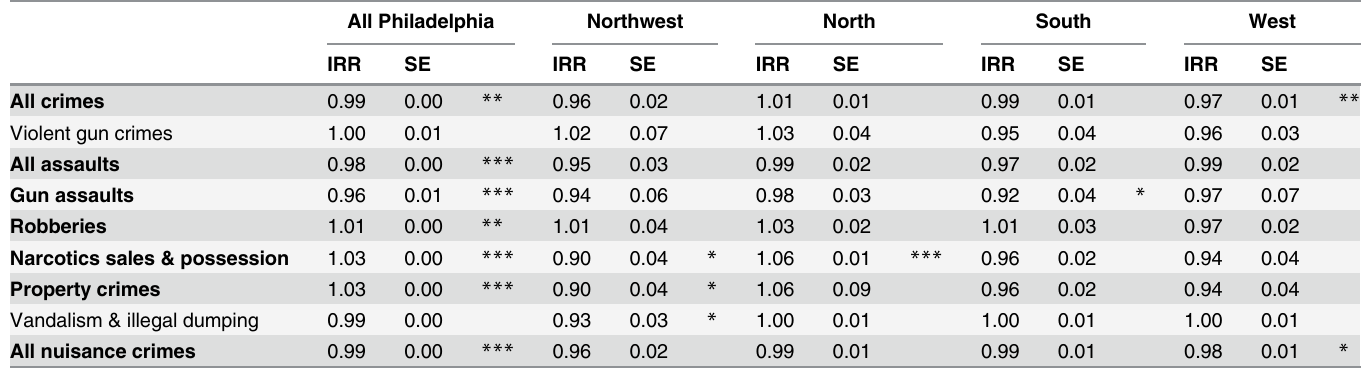
Table 1. Adjusted Difference-in-Differences Estimates of Violation Compliance on Point-Level Crime Outcomes, by City Section, Philadelphia, PA, January 2010 – April 2013 1 . All